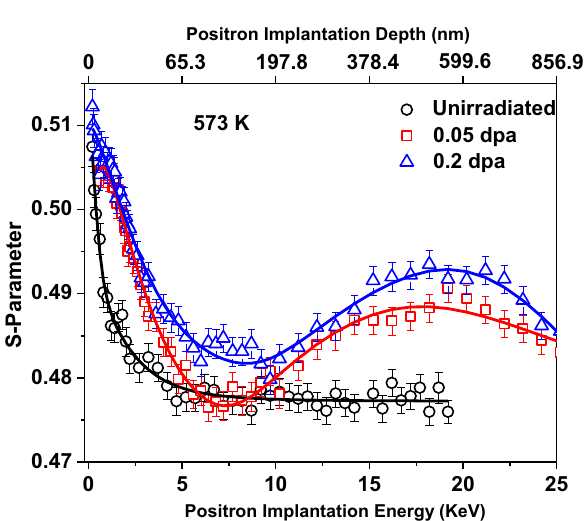
Figure 9. S-E profiles of unirradiated, and irradiated samples with peak dose of 0.05 and 0.2 dpa at 77 K. The solid lines show the fitting of the S-E profiles using VEPFIT.